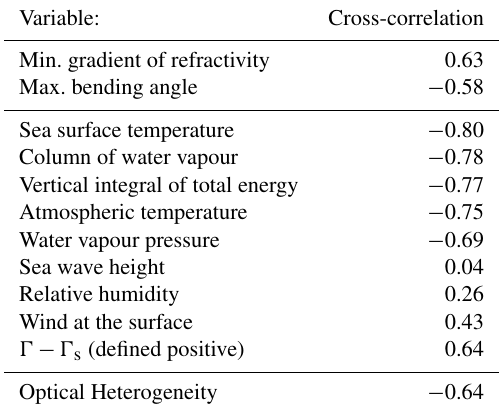
Table 3. Cross-correlation between the percentage of reflected sig- nals in COSMIC ocean events, and other atmospheric variables. Correlations are based on monthly averaged values over 10 ◦ × 10 ◦ ocean cells (see an example in Fig. 8), except the optical hetero- geneity, which is a correlation of individual events. All the variables are obtained from ECMWF ERA Interim analysis, except those ob- tained from the occultation profiles (first two rows), and the het- erogeneity, from Environment Canada’s global forecasts (last row). ERA Interim variables that depend on height have been averaged over the lowest 10km. (cid:48) is the temperature lapse rate, and (cid:48) s is the Saturated Adiabatic Lapse Rate.